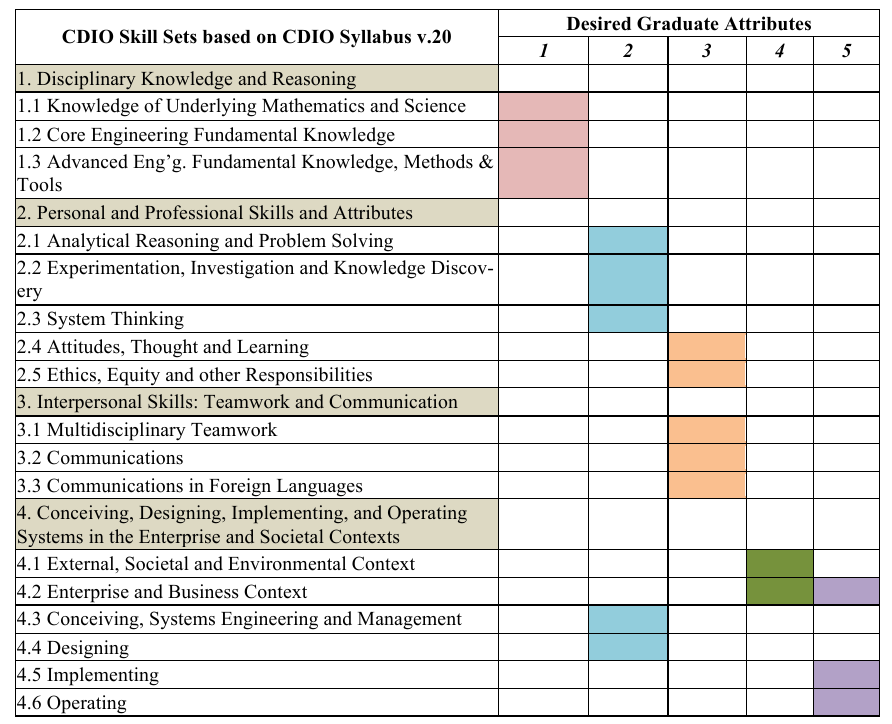
Table 4. CDIO Skillsets-Future Graduate Attributes